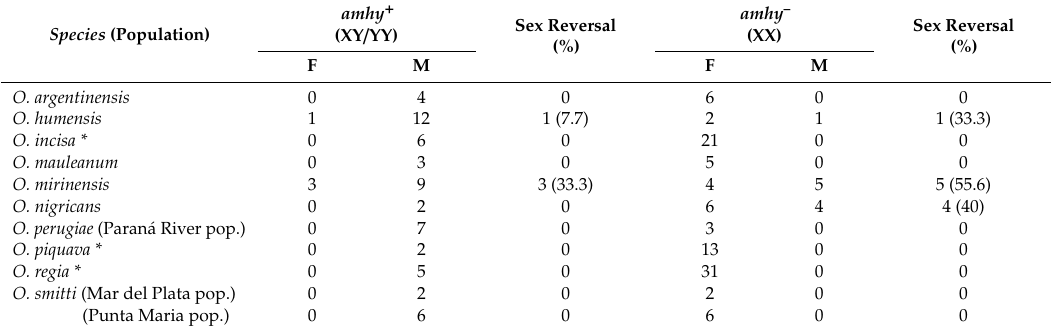
Table 2. Correlation between genotypic and phenotypic sex in Odontesthes